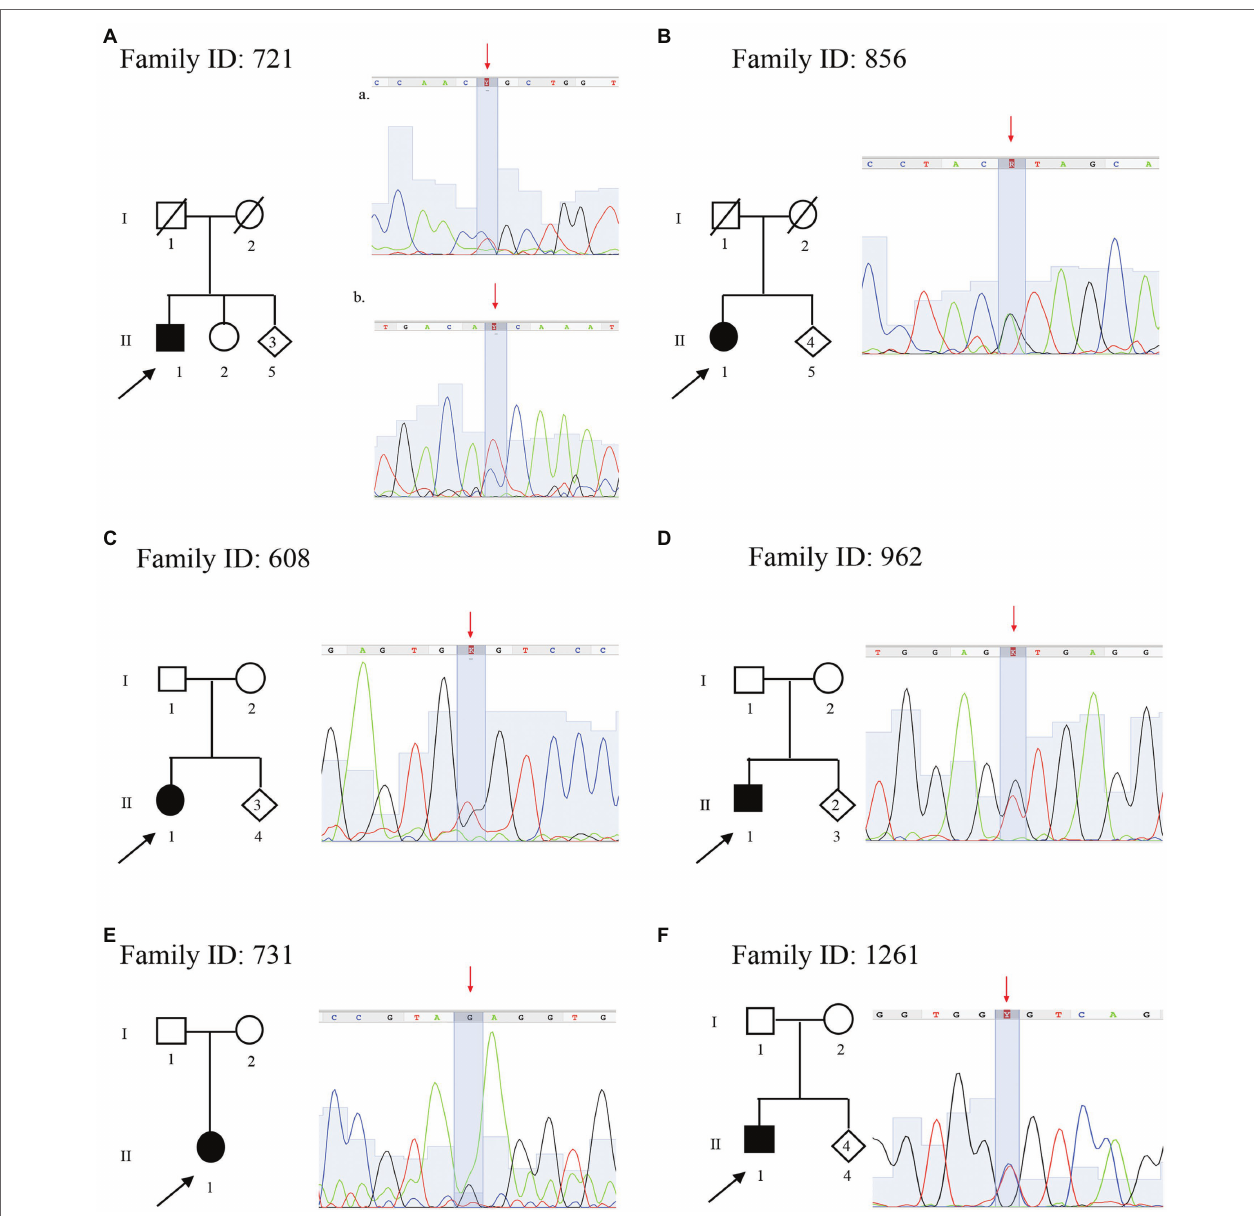
FIGURE 3 | Pedigree and electropherograms of variants of uncertain significance identified by NGS. (A) Family ID: 721, two missense variants in (a) AGRN gene NM_198576.4:c.[5851C > T], NP_940978.2:p.(Arg1951Cys), (rs746117937) and (b) SCP2 gene NM_002979.5 c.[886C > T], p.(Pro296Ser); (B) Family ID: 856, missense variant in DNM2 gene NM_001005360.2:c.[890G > A], NP_001005360.1:p.(Arg297His); (rs763894364); (C) Family ID: 608, missense variant in MED25 gene NM_030973.3:c.[949G > T], NP_112235.2: p.(Gly317Cys); (rs1280659782); (D) Family ID: 962, N missense variant in DYNC1H1 gene NM_001376.4:c. [9919G > T], NP_001367.2:p.(Val3307Leu); (E) Family ID: 731, missense variant in DYNC1H1 gene NM_001376.4:c.[6743A > G], NP_001367.2:p.(Glu2248Gly); and (F) Family ID: 1261, missense variant in BSCL2 gene NM_001122955.3:c.[124C > T], NP_001116427.1:p.(Arg42Cys);